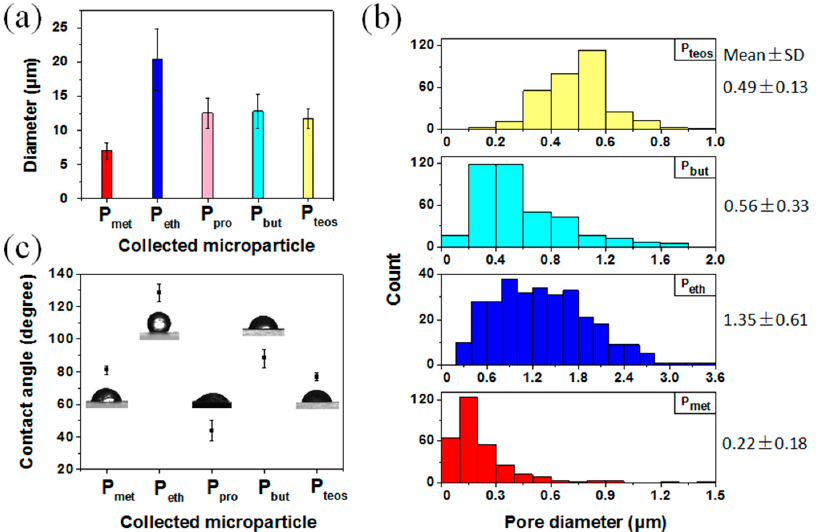
Figure 3. Statistical summary of the various MPs prepared. ( a ) Mean MP size distribution; ( b ) pore diameter distribution; and ( c ) water contact angle of layered MPs with different surface morphologies. P met , P eth , P pro , P but and P teos represent particles collected in methanol, ethanol, 1,2-propanediol, n -butanol and tetraethyl orthosilicate (TEOS), respectively.